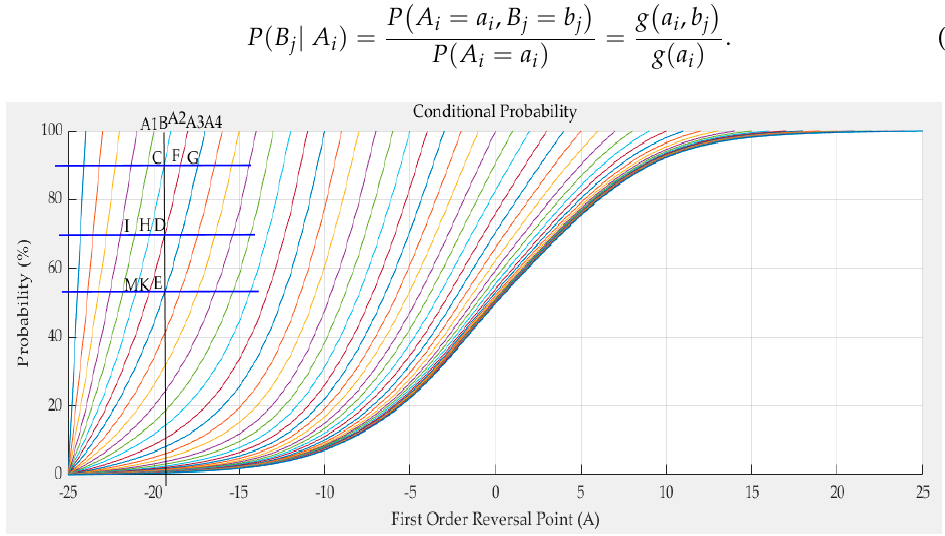
Figure 11. The conditional probability curves.